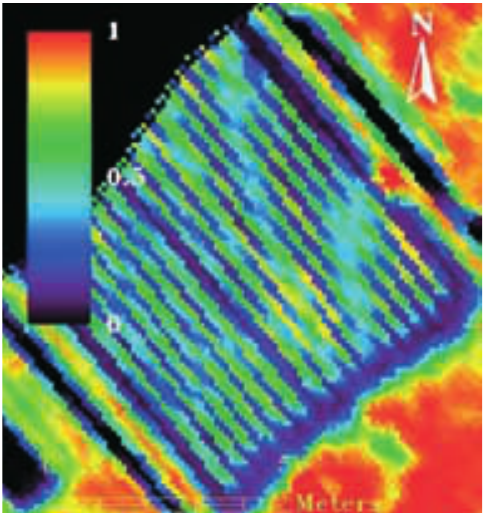
Figure 3. NDVI of the apple orchard